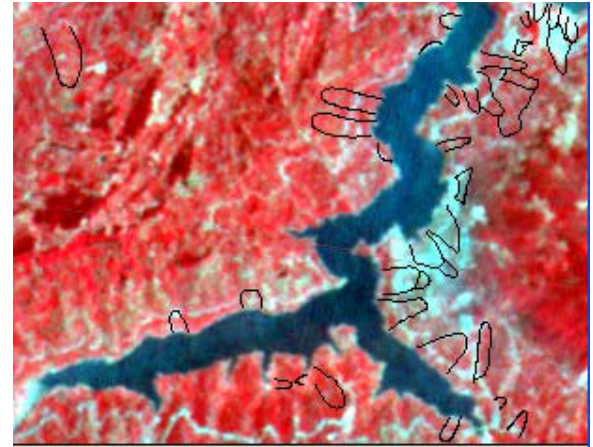
Figure 8. Cbers image piled up with landslide disaster distribution